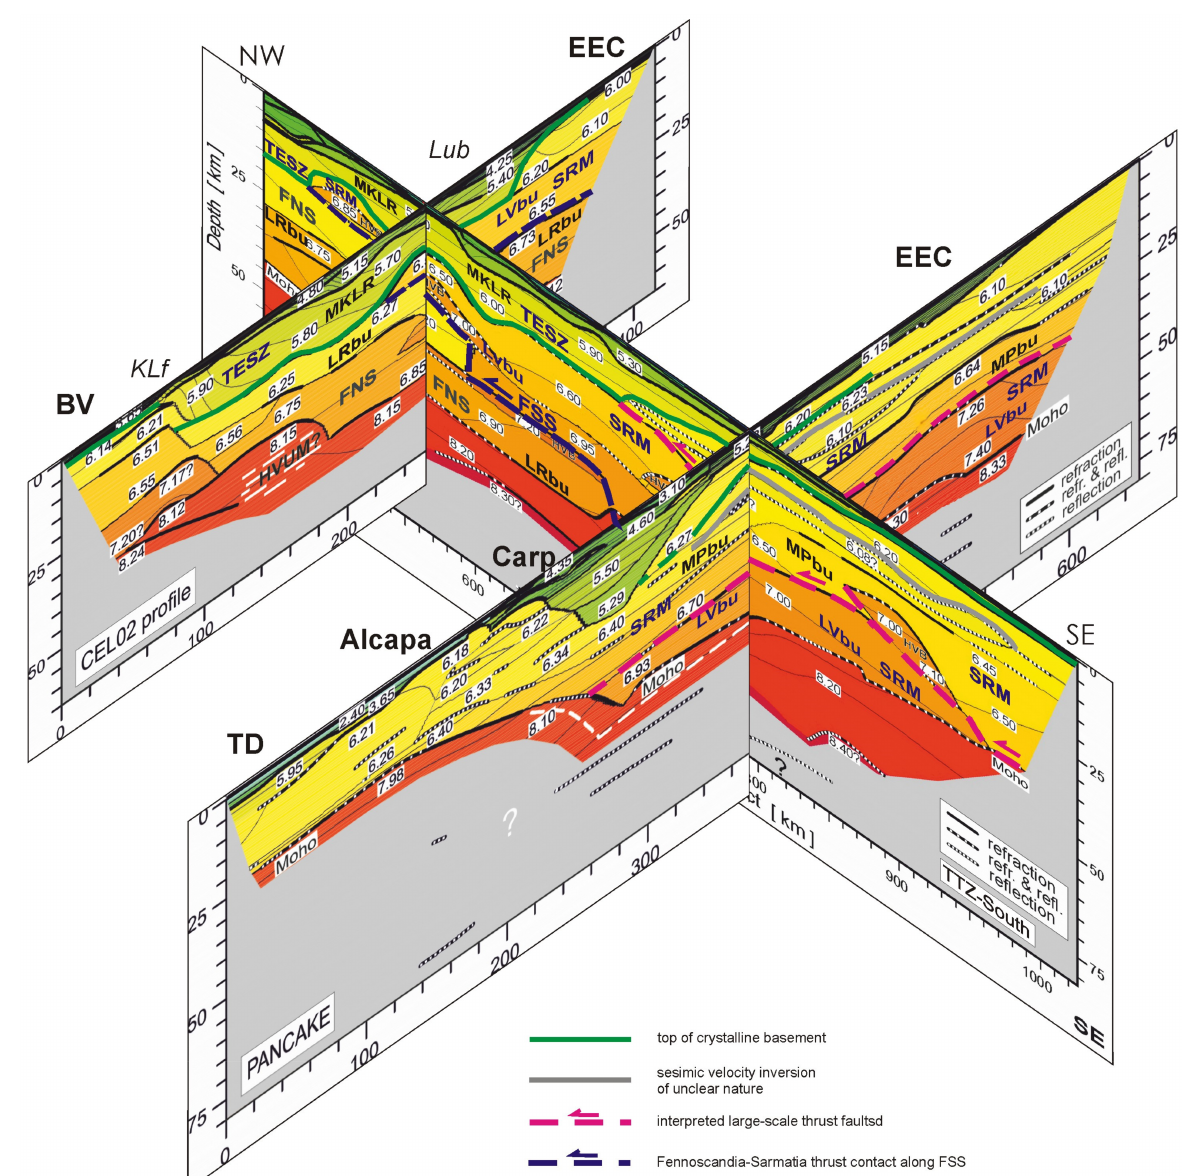
Figure 13. Tectonic relationships across the TTZ-South seismic profile derived from the earlier CEL02 and PANCAKE profiles running at a high angle to it (for location see Figure 1). For simplicity, the profiles are assumed to intersect at 90 ◦ and no attempts were made to reduce depth discrepancies of the same features interpreted on different profiles. Abbreviations: BV—Brunovistulian terrane;